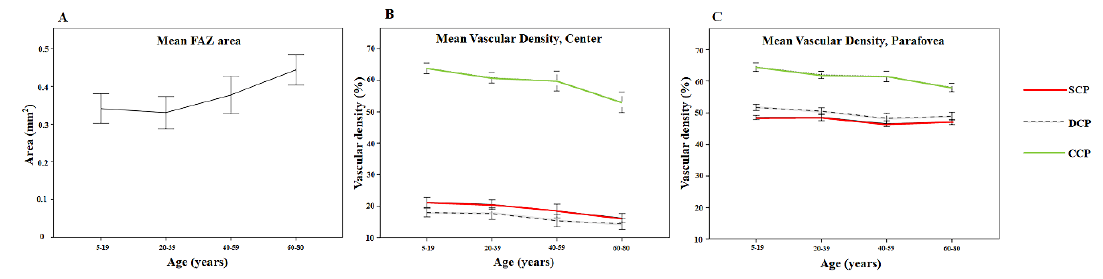
Figure 2. Line graph showing the relationship between age and FAZ area (mm 2 ) ( A ), central mean vessel densities (%) ( B ), and parafoveal mean vessel densities (%) ( C ). Error bars represent one standard deviation.